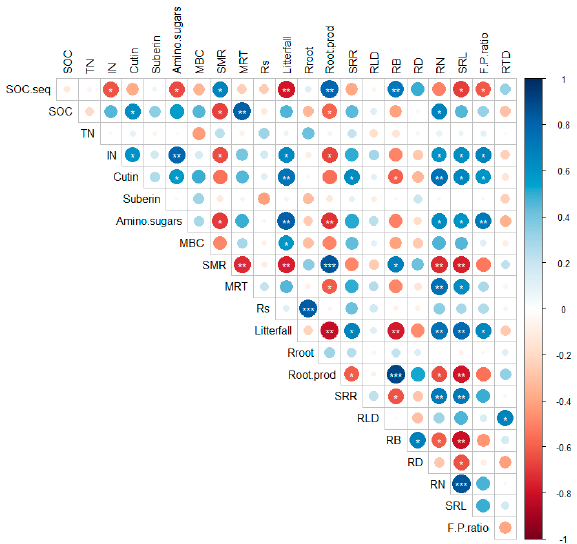
Figure 6. Relationships among SOC accumulation rate, fine-root functional traits, and soil properties. The size of the circle is proportional to the R 2 value. Blue dots indicate a positive correlation, while red ones are negative. Abbreviations: SOC seq: SOC sequestration, IN: inorganic nitrogen, SRS: specific root respiration, MRT: mean carbon residence time, SMR: specific microbial respira- tion, R s: soil respiration, RLD: root length density, RMD: root mass density, Root N: root nitrogen concentration, SRL: special root length, F.P. root. ratio: fibrous/pioneer root ratio, RTD: root tissue density, R root : root respiration, MBC: microbial biomass carbon. Stars represent statistical signifi- cance: * p < 0.05 , ** p < 0.01, *** p < 0.001. 3.4. Soil C Residence Time and Specific Microbial Respiration Based on the monthly measurement in 2018, microbial respiration ( R H ) was 2.51, 2.05, and 2.12 μ mol CO 2 m − 2 s − 1 on average at the early, middle, and late stages of forest succes- sion, respectively, with no significant difference among the three stages (Figure 5a–c, p > 0.05). Soil C residence time, which was calculated as the ratio of SOC stock to annual R H , was 397 years at the early-successional stage, which was lower than that at the late one (613 years, Figure 5e, p < 0.05). Soil microbial C biomass (MBC) was 792 mg kg − 1 on average at the late-successional stage based on the seasonal measurement, which was greater than that at the early-successional stage (689 mg kg − 1 , Figure 5d, p = 0.07). Specific microbial respiration (i.e., the ratio of annual R H to MBC stock) was 12.1 mg CO 2 -C g − 1 MBC h − 1 at the early-successional stage, which was significantly greater than that at the mid- (9.35 mg